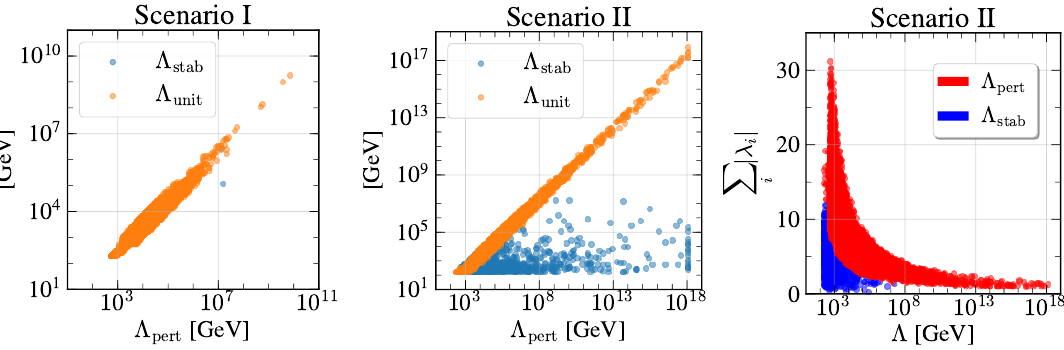
Figure 3 . (Left & Middle): the breakdown energy scales of unitarity and stability as functions of the perturbativity violation scale in scenario I and II respectively. (Right): the summed magnitude of quartic couplings at the starting scale vs. the perturbativity and stability breakdown-energy